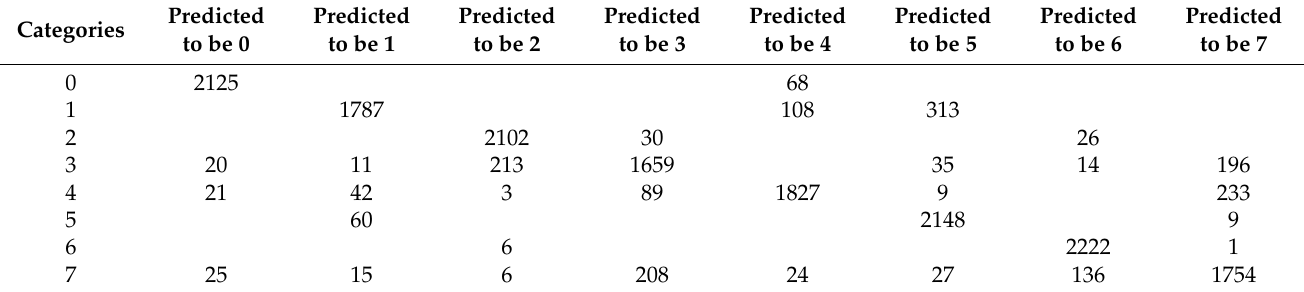
Table 5. Multi-classification confusion matrix of Stacking model drilling